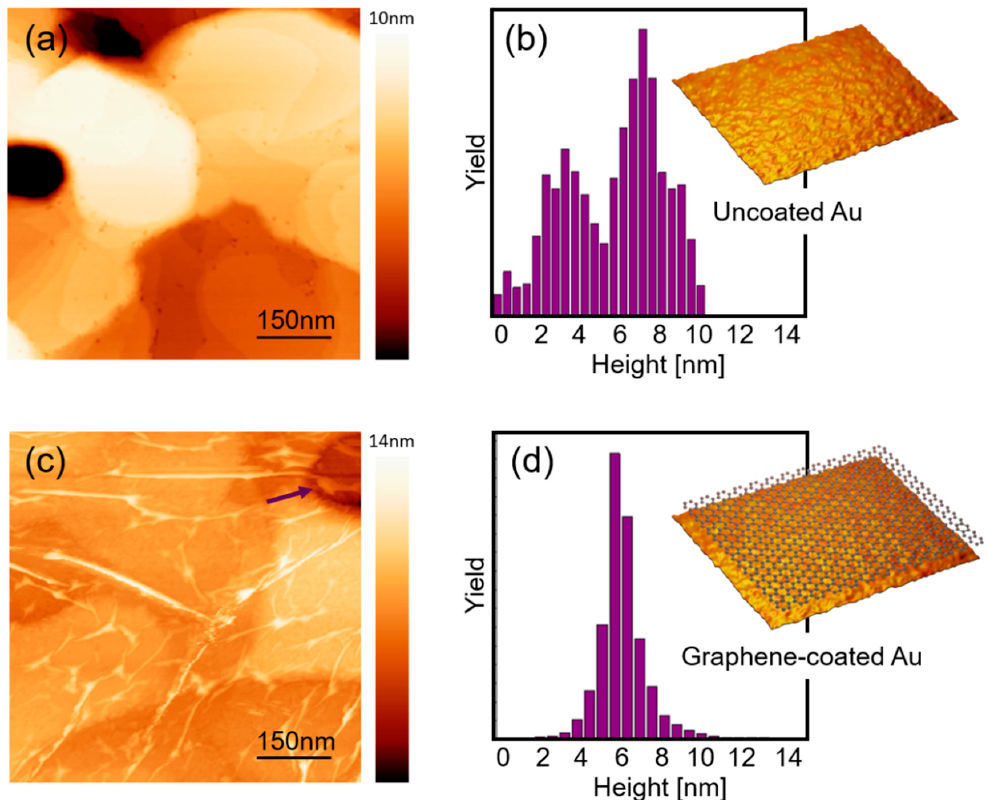
Figure 3. Topographic STM images of ( a ) uncoated Au (750 × 750 nm 2 , I = 0.1 nA, V BIAS = 0.6 V) with its corresponding surface roughness ( b ). ( c ) Graphene-coated Au samples (750 × 750 nm 2 , I = 0.03 nA, V BIAS = 0.9 V). with is corresponding roughness ( d ).